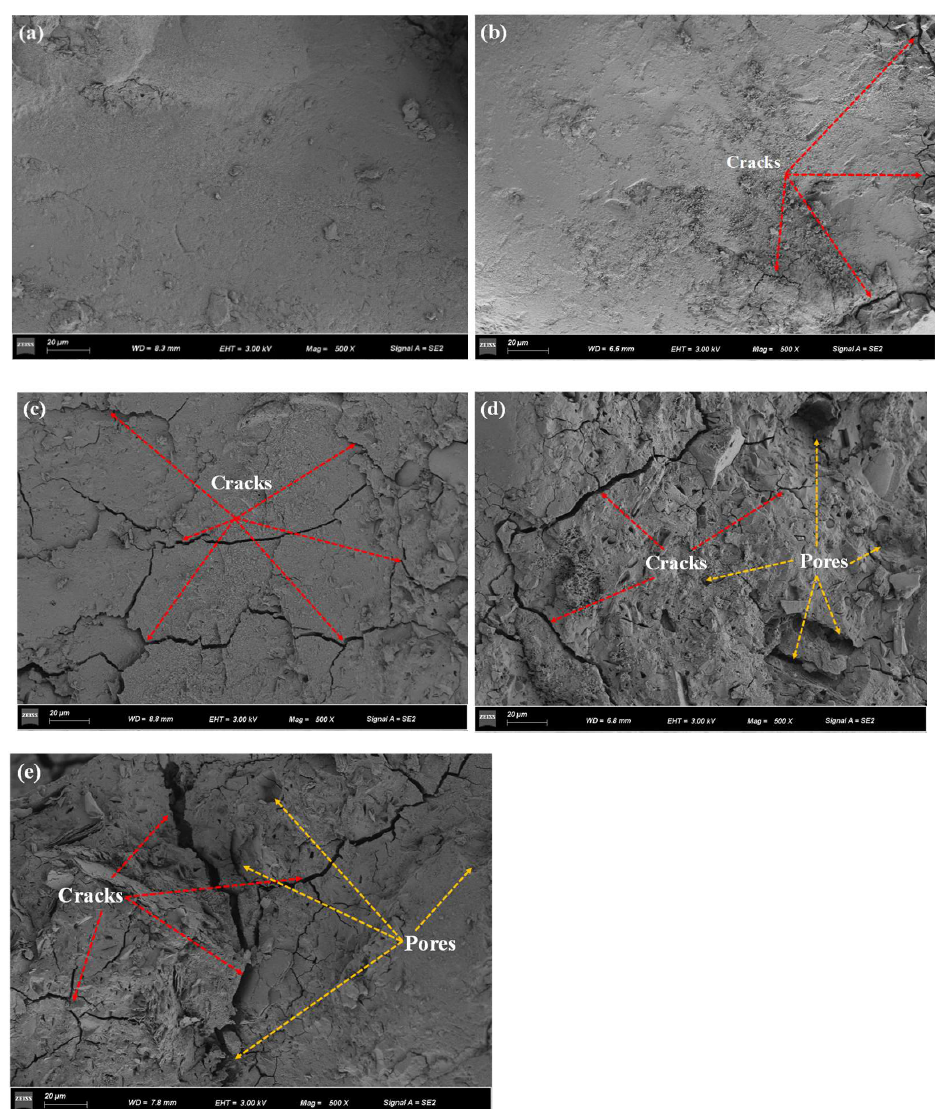
Figure 8. Microstructural cracking patterns of specimens after ( a ) 0, ( b ) 25, ( c ) 50, ( d ) 75, and ( e ) 100 freeze–thaw cycles.